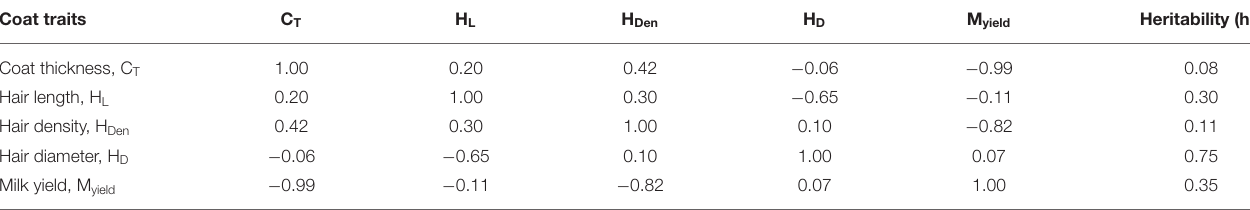
TABLE 1 | The genetic correlations between the hair coat traits and milk yield in Brazilian Holstein cattle population. Coat traits C T H L H Den H D M yield Heritability (h 2 ) Coat thickness, C T 1.00 0.20 Hair length, H L 0.20 Hair density, H Den Hair diameter, H D − 0.06 Milk yield, M yield − 0.99 − 0.11 Data from 1,500 Brazilian Holstein cows (37, 38,